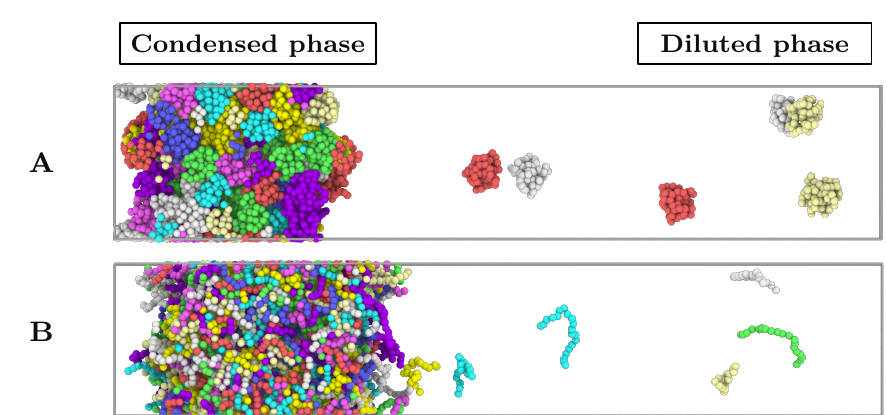
Figure 2. Direct coexistence simulation box of: ( A ) 128 interacting globular proteins of length N = 80 at T ˚ “ 2.5. ( B ) 512 intrinsically disordered proteins of length N = 20 at T ˚ “ 2.25. Individual proteins are depicted by different